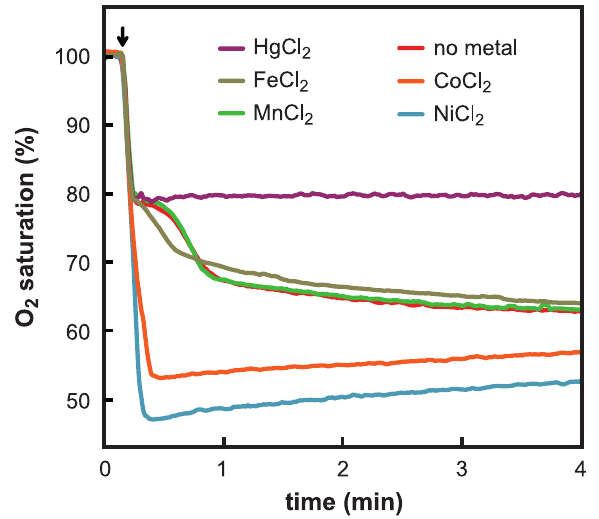
Figure 4. Effect of metal ions on dioxygen consumption during oxidation of sodium selenide. Dissolved dioxygen (O 2 saturation percentage) was measured as a function of time in samples initially containing 1.28 ml of the indicated metal (125 m M). At time 10 s (as indicated by the arrow), 320 m l of an anaerobically prepared solution of sodium selenide was added to give final concentrations of 100 m M metal and 100 m M selenide. This mixing caused instantaneous drop in the dioxygen saturation level, from 100% (234 m M) to 80% (187 m M). After this drop, dissolved oxygen concentration varied depending on the assayed metal. At longer times, slight increases in dioxygen concentration were observed in the samples containing mercury, cobalt or nickel ions. These increases originate from slow diffusion of ambient air in the open vials used for the experiments. These slight increases are expected to also occur in the experiments with manganese or iron or without metal.